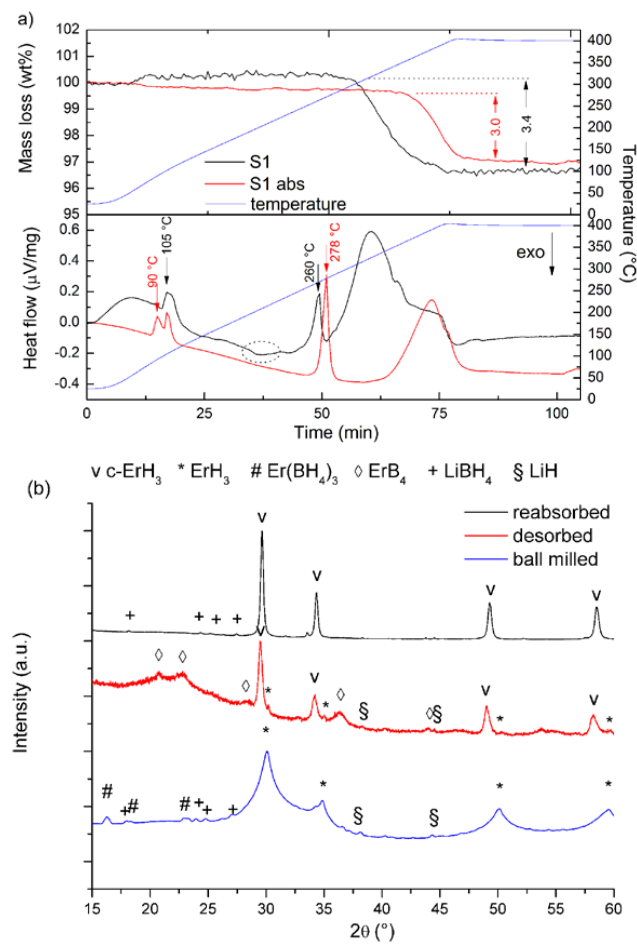
Figure 2. ( a ) TG-DSC data of ball milled S1 (black curves) and reabsorbed S1 (S1 abs) (red curves), showing TG data (top) and DSC signal (bottom). X -axis in time (min) as the heating from RT to 400 °C proceeded with a 30-min isotherm. Temperature (°C) is given on the secondary y -axis to the right; ( b ) Ex situ PXD data of S1 showing one absorption-desorption cycle with ball milled (bottom), desorbed (middle), and reabsorbed (top) composite. λ = 1.54056 Å.